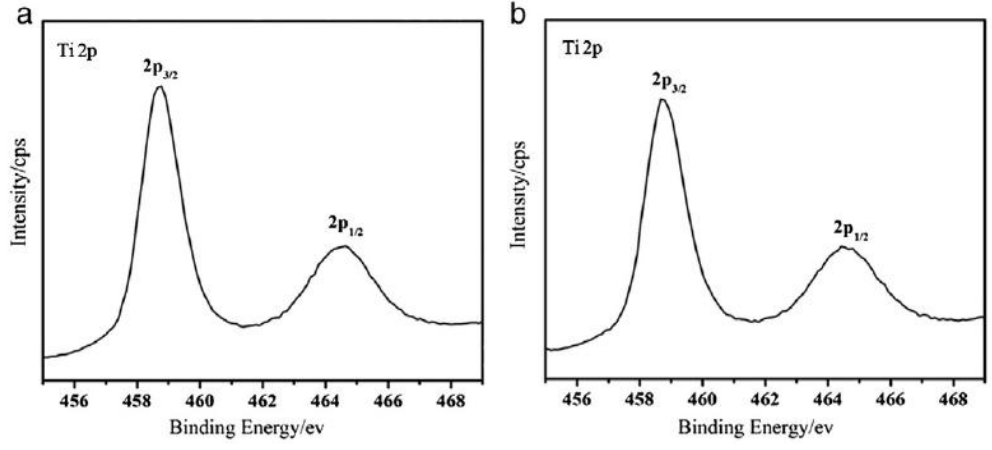
Figure 19. X-ray Photoelectron Spectroscopy (XPS) spectra of the Ti 2p region of mesoporous TiO film calcined at ( a ) 350 °C; ( b ) 450 °C; O 1s spectra of TiO 2 calcined at ( c ) 350 °C; and ( d ) 450 °C. Inset shows the contact angles. Reprinted with permission from [44]. Copyright 2012